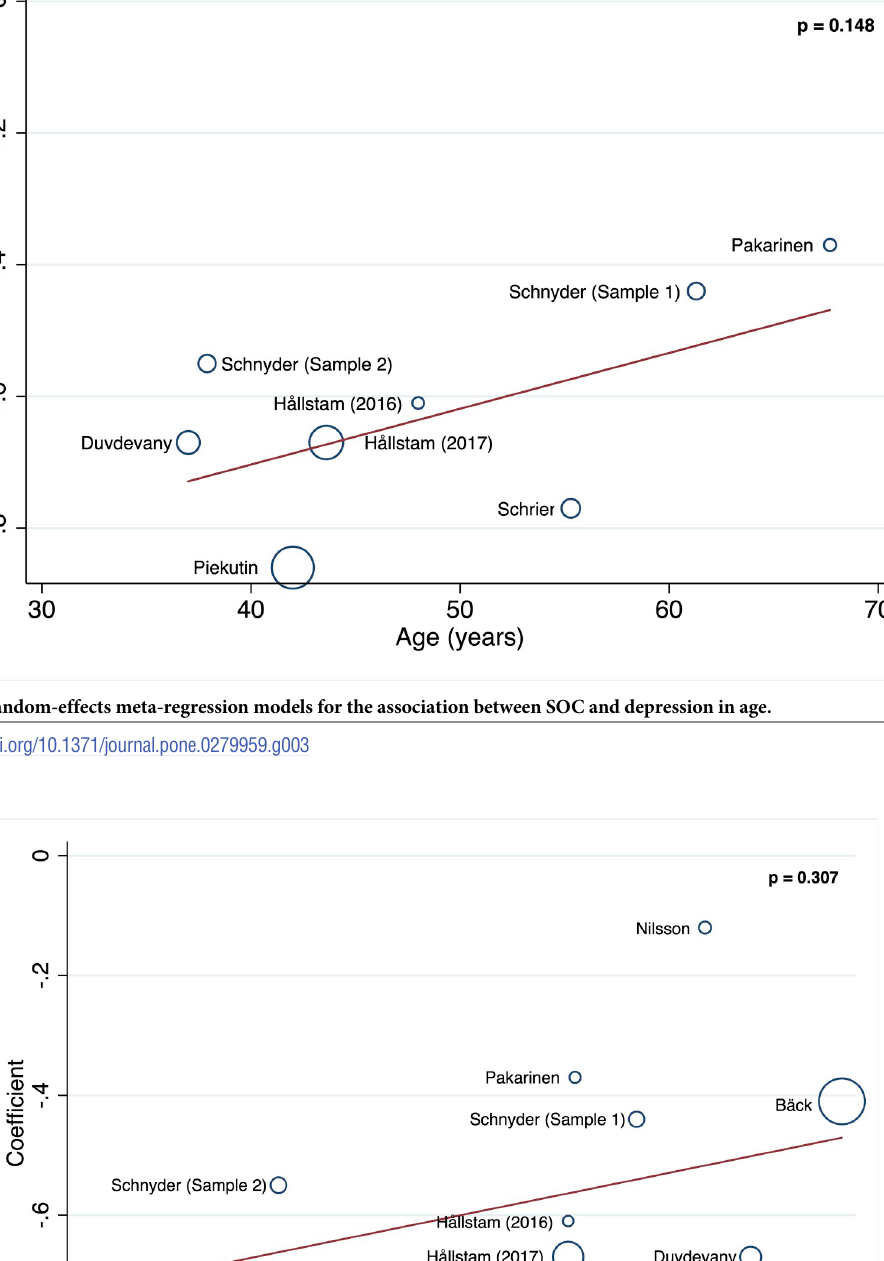
PLOS ONE | https://doi.org/10.1371/journal.pone.0279959 January 11,